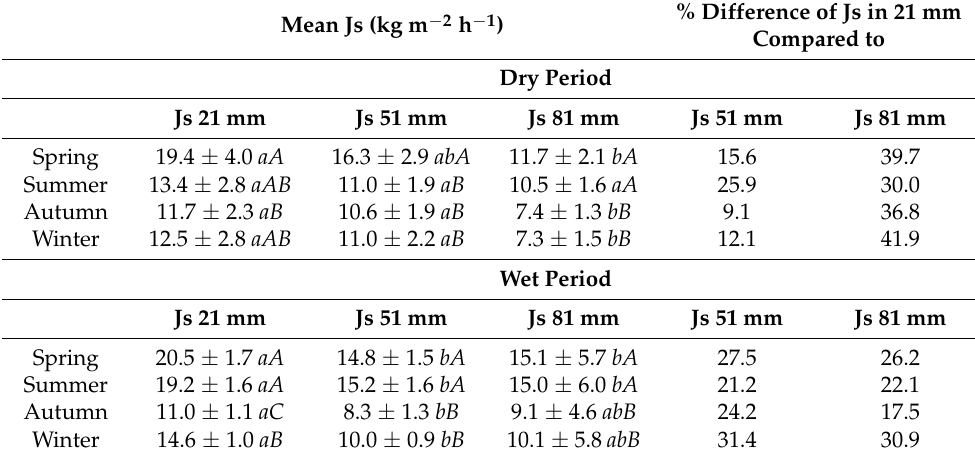
Table 3. Mean diurnal Js ± SE in the 3 different sapwood depths and in the different seasons during the two study periods (Dry period: July 2008–November 2009; wet period: April 2018–April 2020). The difference (%) between Js at 21 mm and Js at the two inner depths is also shown. Lowercase different letters indicate significant differences between the 3 sapwood depths, within each season, while uppercase different letters indicate significant differences among the seasons.